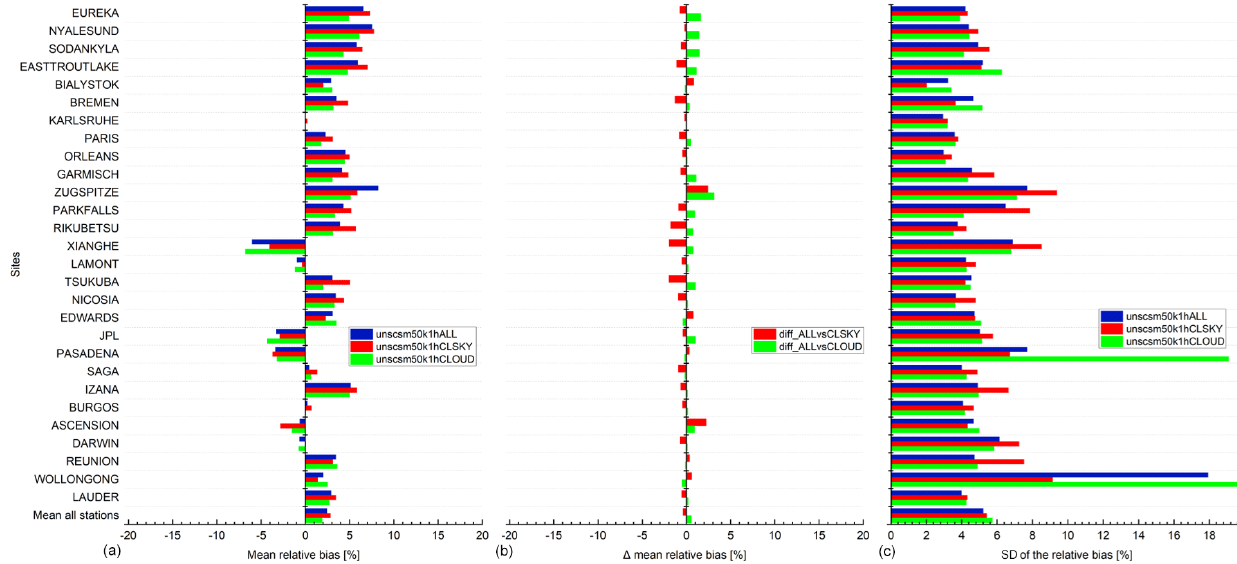
Figure 33. S5P XCO (ALL, CLSKY and CLOUD cases) validation results against TCCON XCO data at 28 stations within the period between November 2017 and September 2020. (a) Bar chart of mean relative bias ((SAT – GB)/GB) in percent; (c) standard deviation of the relative bias in percent; (b) difference of the mean relative bias for validation cases (unscsm50k1hCLSKY, unscsm50k1hCLOUD) in percent against the reference case (unscsm50k1hALL) in percent. Spatial co-location with radius of 50km and time co-location of ± 1h around the satellite overpass was used. The stations are sorted with decreasing latitude.